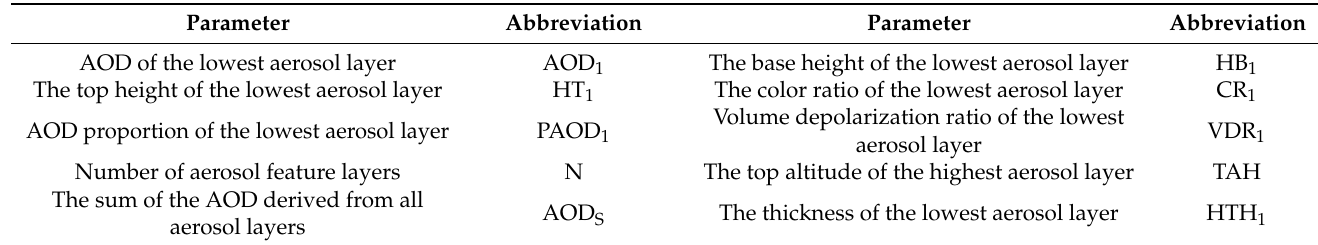
Table 1. The list of abbreviations of aerosol optical physical parameters in this